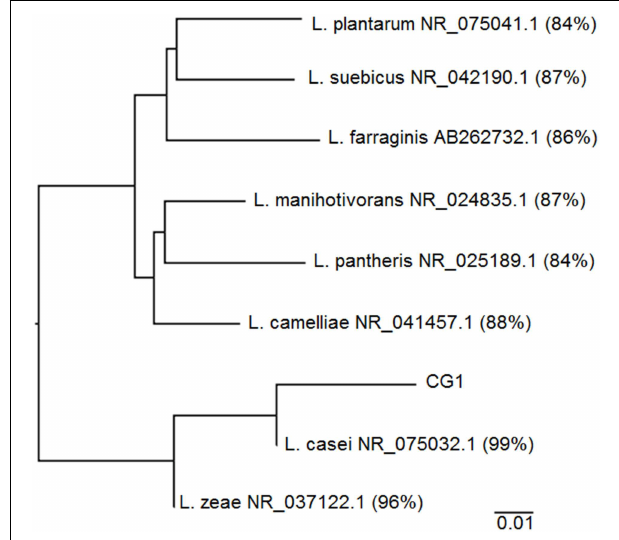
FIGURE 3 | Phylogenetic tree showing CG-1 in relation to other organisms belonging to the genus Lactobacillus . Lactobacillus species include Genbank accession numbers as well as percent alignment to CG-1 using the neighbor joining method on